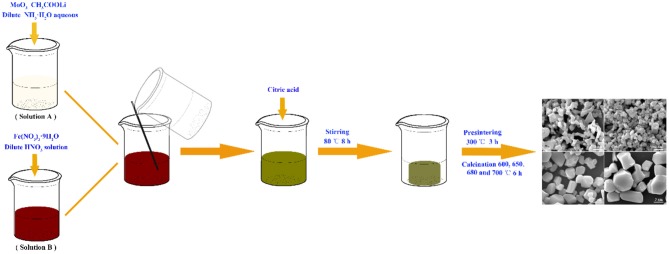
Schematic representation for the preparation of LiFe(MoO4)2 microcrystals.